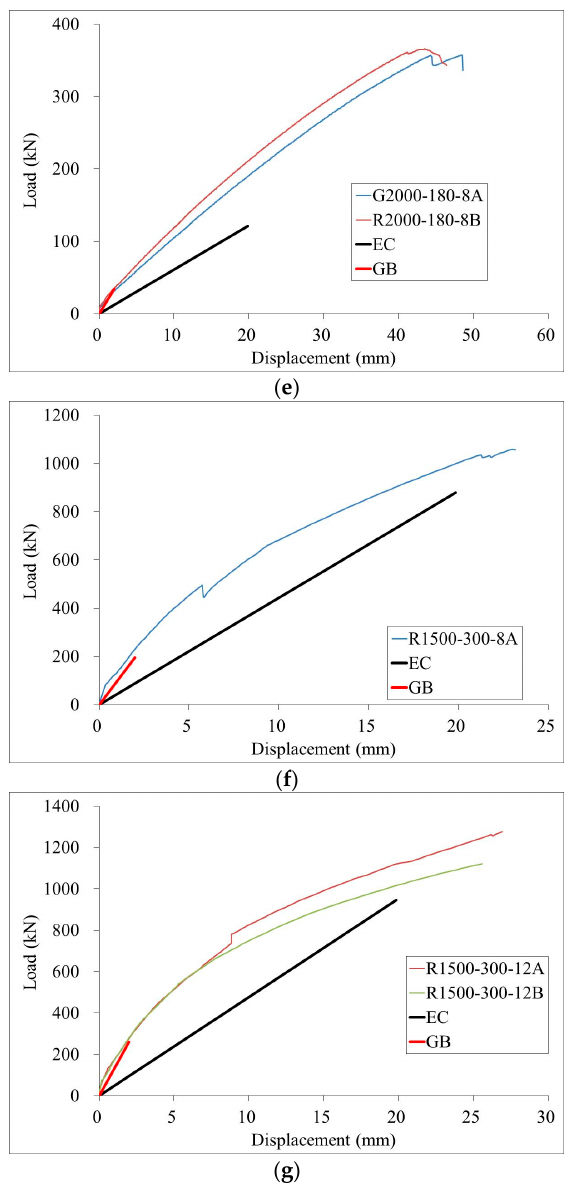
Figure 5. Load-displacement curves of test specimens and predictions ( a ) Series G2000-300-8 ( b ) Series G2000-300-12 ( c ) Series R2000-300-8 ( d ) Series R2000-300-12 ( e ) Series 2000-180-8 ( f ) Specimen R1500-300-8A ( g ) Series R1500-300-12 (Note: GB is prediction from GB Standard [16] and EC is prediction from Eurocode [17]).